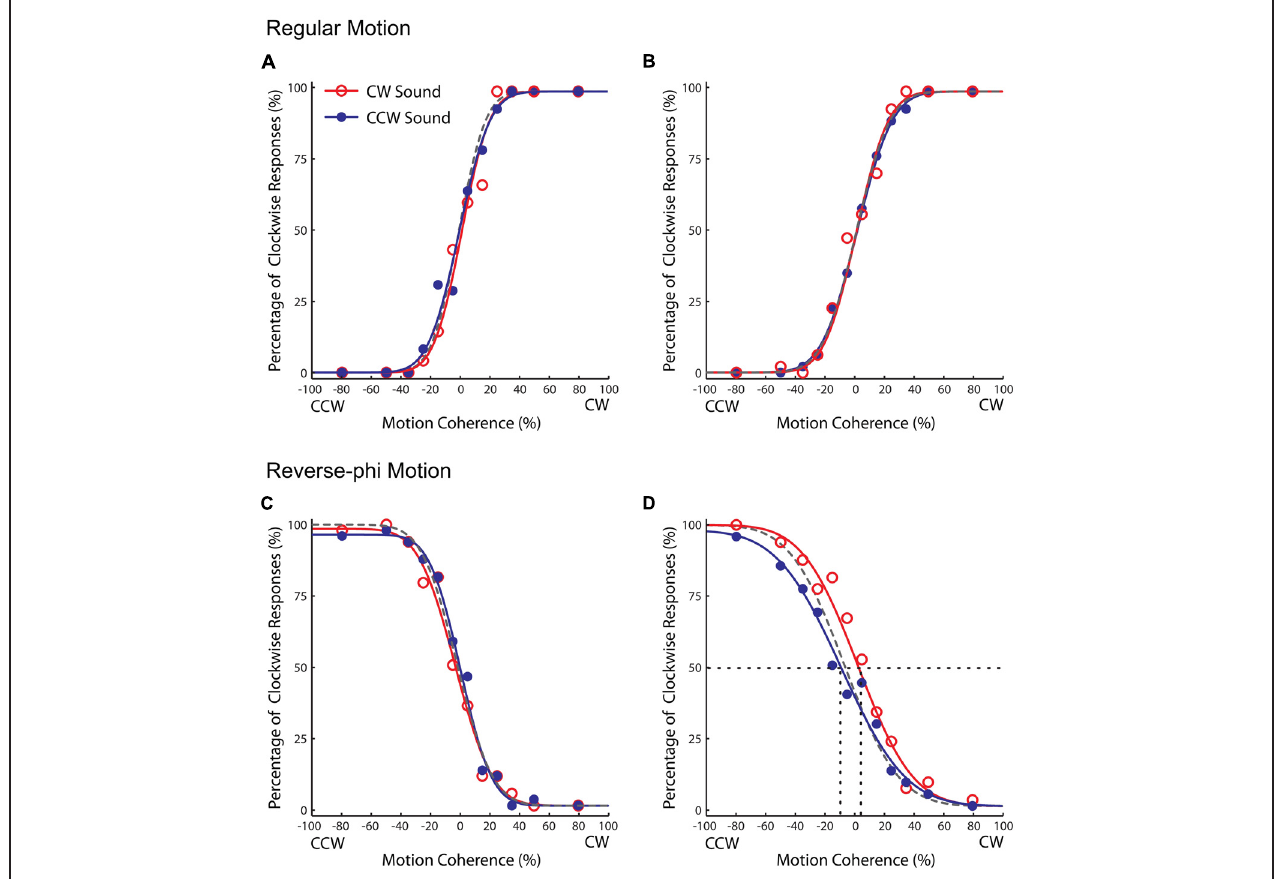
FIGURE 4 | Results of Experiment 2 (reverse-phi motion used in the association phase). Group averaged data ( n = 6, five were naïve observers) for different experimental conditions. Top panel: pre-association (A) and post-association (B) data for regular motion. Bottom panel: